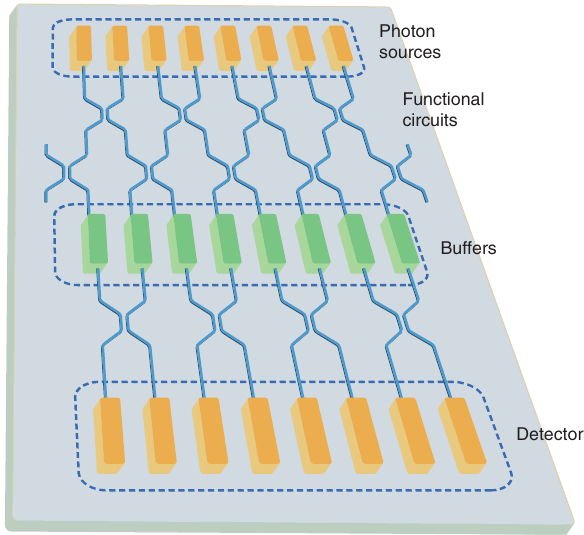
Figure 1: Conceptual diagram of a photonic quantum processor based on integrated quantum photonics.